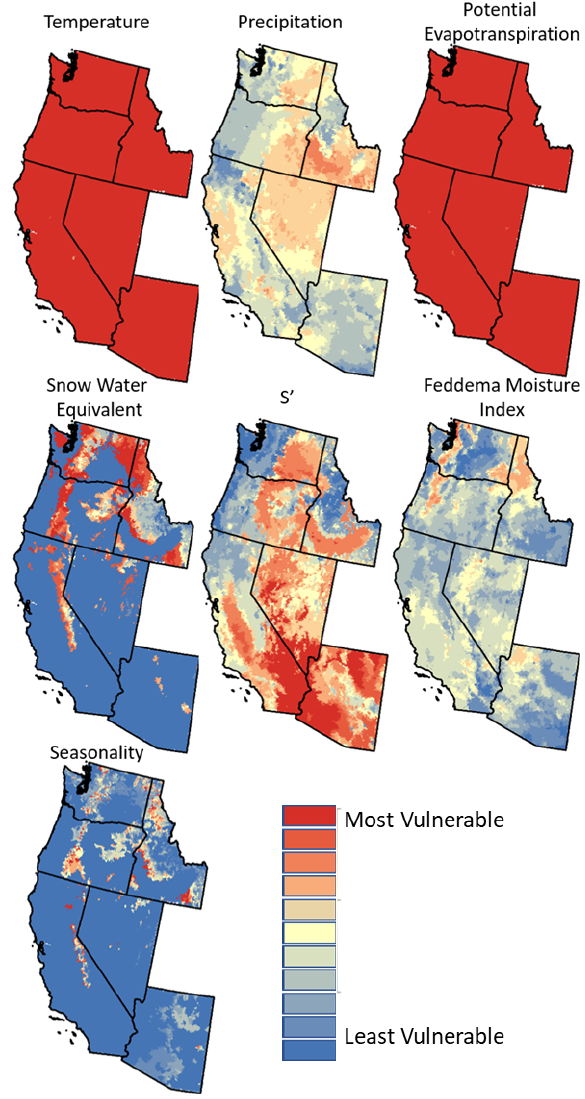
Figure 4. Vulnerability indices for temperature, precipitation, po- tential evapotranspiration, snow water equivalent (1 April), S (cid:48) (available water), Feddema Moisture Index, and seasonality. The least vulnerable locations are those projected to be within 2 stan- dard deviations of the historic (1901–2010) mean in all 10 climate